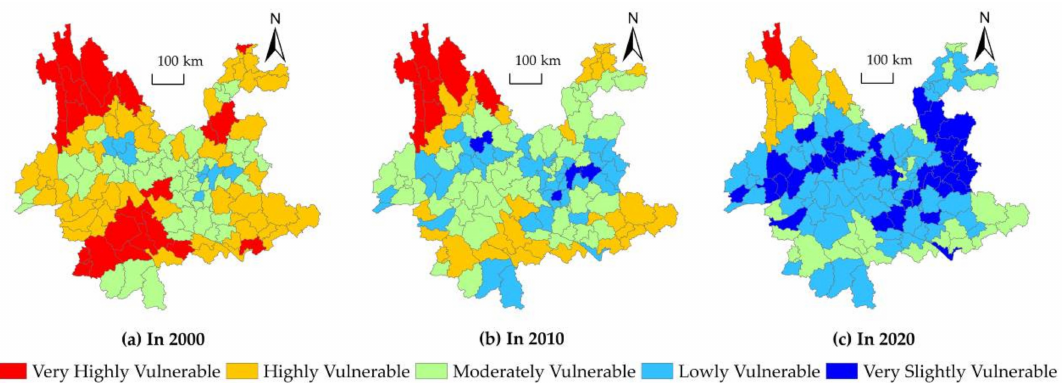
Figure 4. Ecological vulnerability evaluation of rural areas in Yunnan Province from 2000 to 2020.